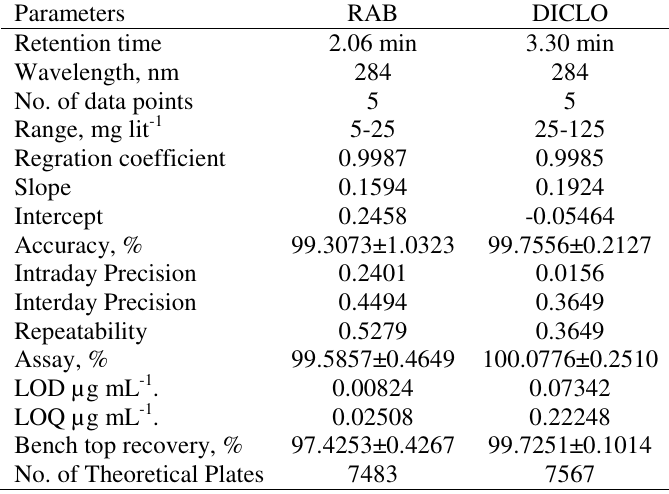
Table 2. Validation